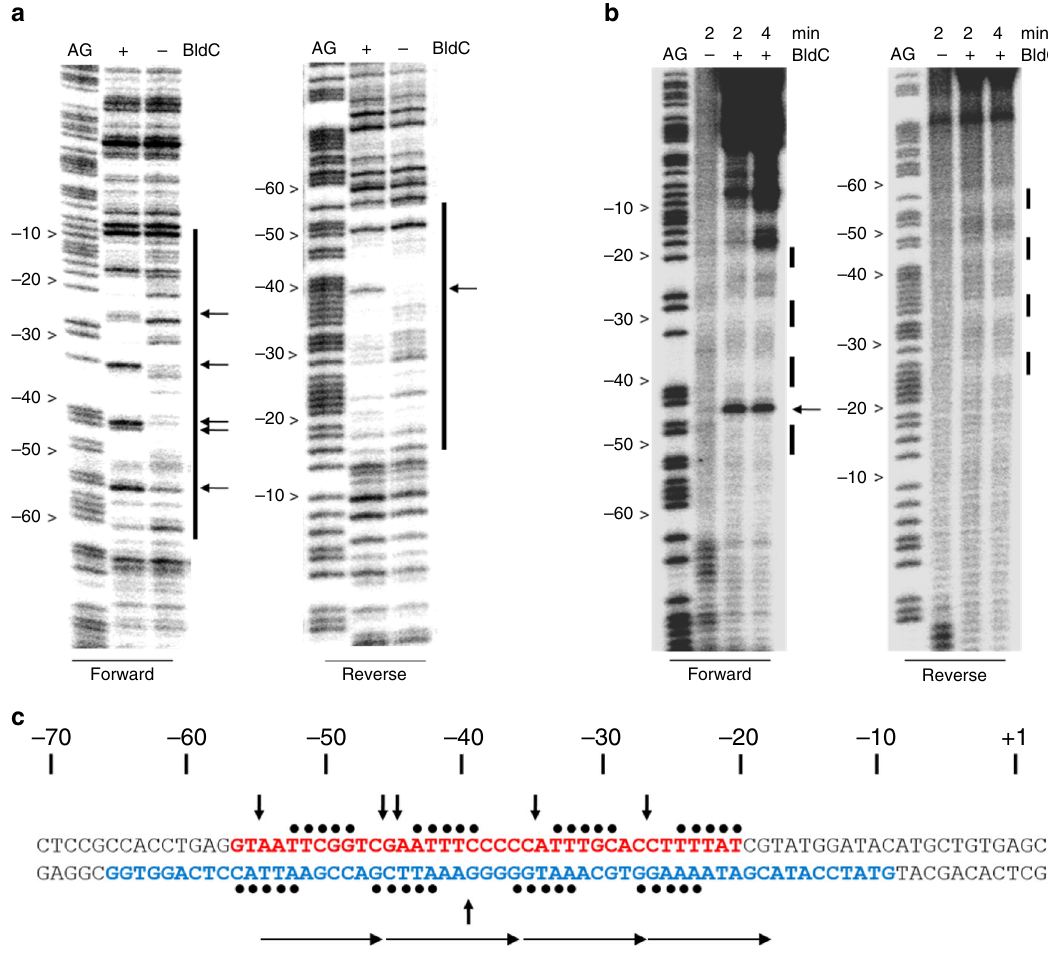
Fig. 3 BldC binding to the smeA-ssfA promoter region. a DNase I and b hydroxyl radical footprinting analysis. 5 ′ end-labeled probes were incubated in the presence (1 µ M) or absence of BldC and subjected to footprinting analysis as described in Methods. Footprints are fl anked on the left-hand side by Maxam and Gilbert sequence ladders (AG). Horizontal black arrows indicate sites of enhanced cleavage and vertical bars indicate regions of DNase I protection. c Summary of the footprinting results presented in a and b . The fi lled black circles indicate the repeat pattern of bases protected from hydroxyl radical attack. The bases colored red and blue indicate the DNase I-protected sequences on the forward and reverse strands, respectively, and the vertical black arrows indicate the repeat pattern of DNase I hypersensitive sites seen on the top strand in the presence of BldC. The numbers indicate the distance to the 5 ′ end of the smeA transcript. Direct repeat motifs are indicated by head-to-tail